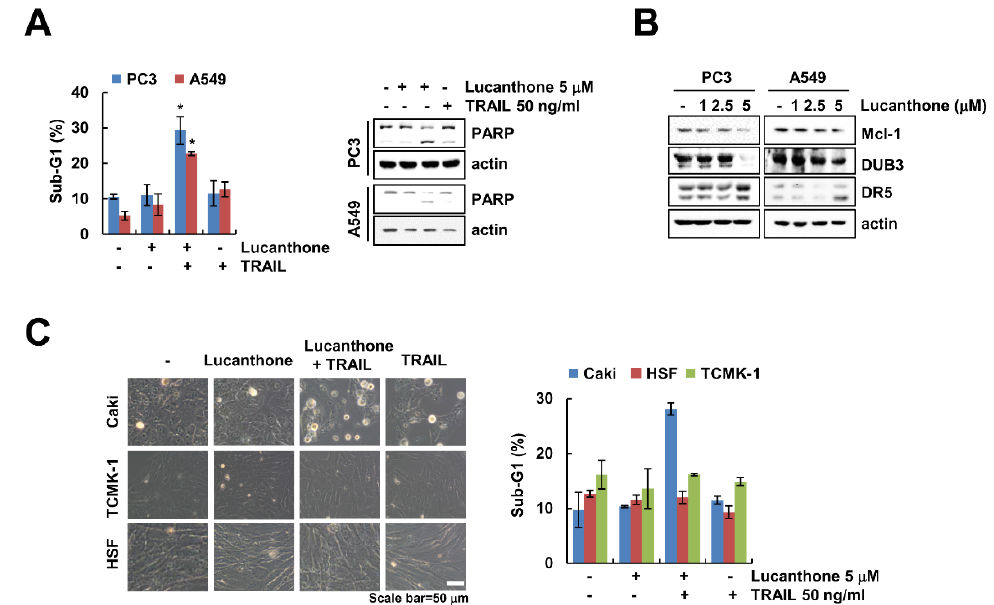
Figure 6. Effects of lucanthone on TRAIL sensitization in other cancer cells and normal cells. ( A–C ) Human cancer cell lines (prostate cancer; PC3 and lung cancer; A549) and normal cell lines (HSF and TCMK-1) were treated with ( A,C ) a combinations of 5 μM lucanthone with 50 ng/ml TRAIL or ( B ) 1–5 μM lucanthone for 24 h. ( A,C ) The sub-G1 population and ( A,B ) protein expression were measured by flow cytometry and Western blotting, respectively. ( C ) Cell morphology was imaged by interference light microscopy. The values in graph ( A,C ) represent the mean ± SD of three independent samples. * p < 0.05 compared to control.